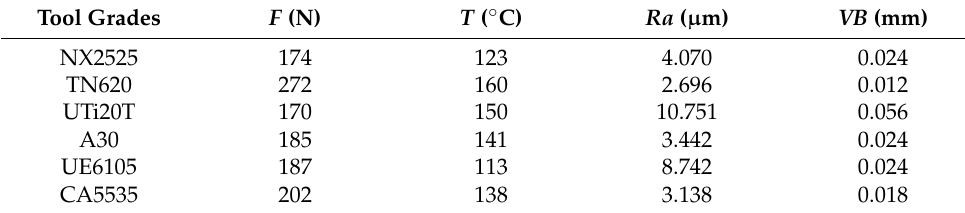
Table 3. Results of turning experiments at the cutting speed of 40 m/min.